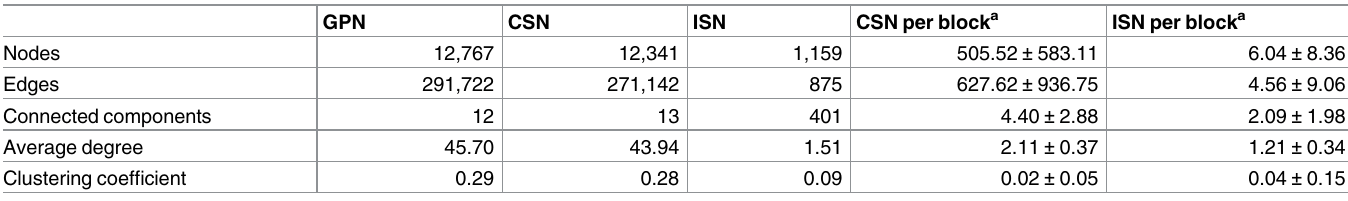
Table 2. Network statistics for the global protein network (GPN), the complete synteny network (CSN) and the internal synteny network (ISN). GPN CSN ISN CSN per block a ISN per block a